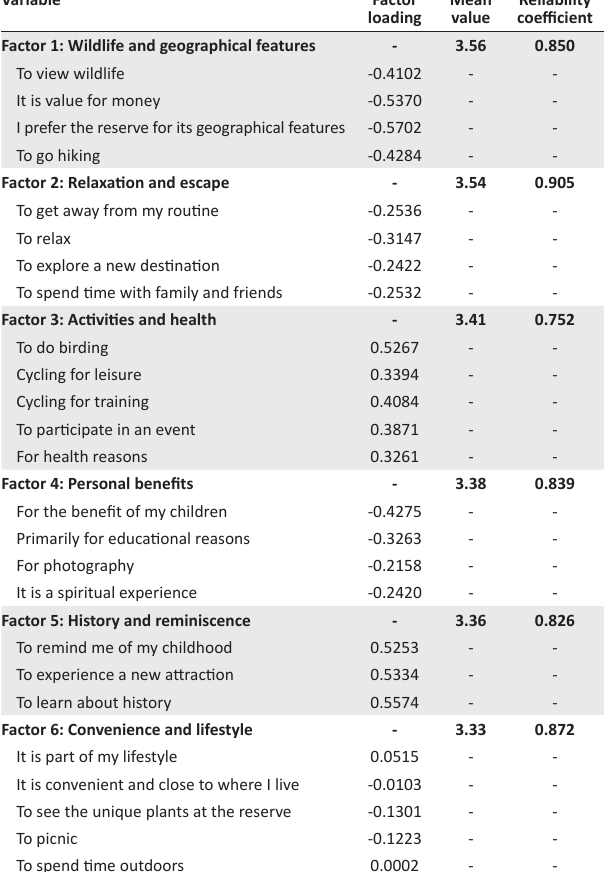
TABLE 3: Results of factor analysis.